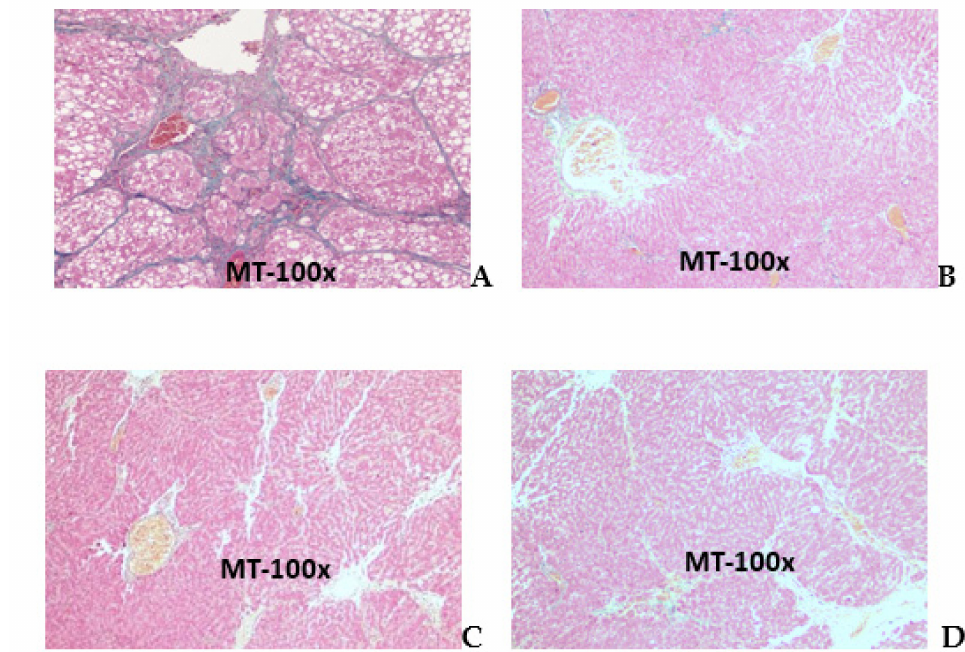
Figure 5. Photomicrographs of rat liver stained with Masson